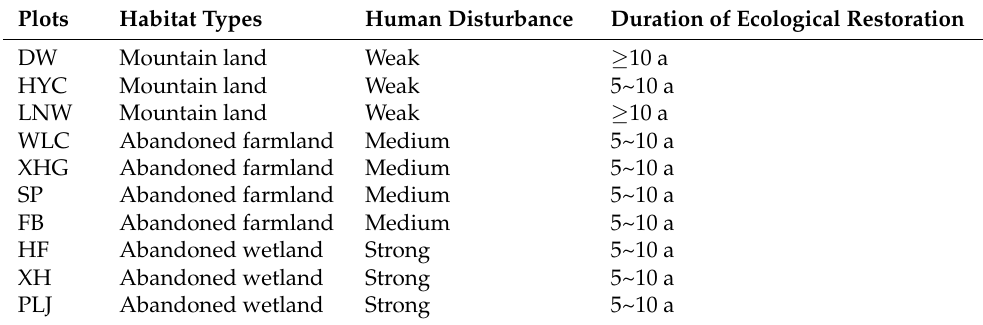
Table 1. Condition of 10 typical plots in the three habitat types along Dianchi lakeside. Plots Habitat Types Human